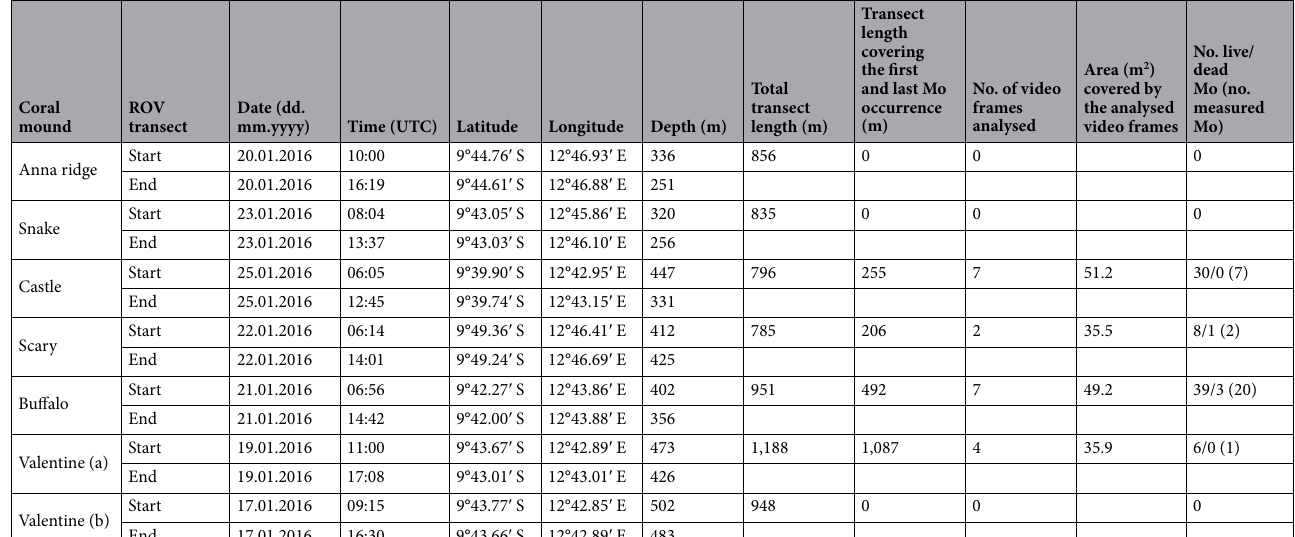
Table 1. Metadata of seven ROV video surveys conducted across six Angolan coral mounds during RV Meteor cruise M122. For the location of the ROV dives see Fig. 2. The number of live and dead occurrences of Madrepora oculata (No. live/dead Mo) as well as colonies for which size measurements were conducted (No. measured Mo; given in brackets) observed during the analyses of the down-look video frame are indicated for each